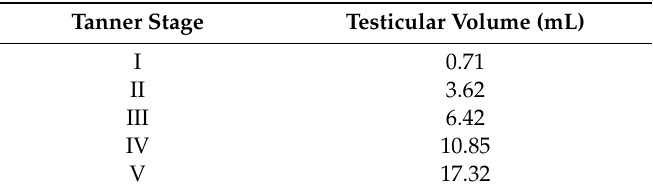
Table 1. Testicular volume values according to the Tanner stage. Legend: The testicular volume is reported as median value